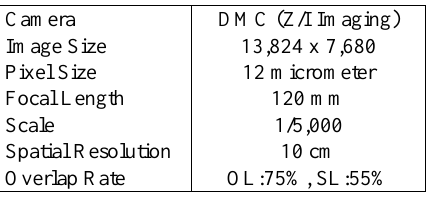
Table 10. Specification of Aerial Photograph